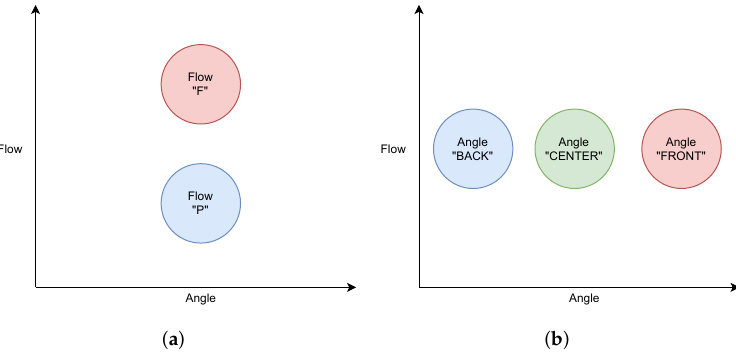
Figure 8. Ideal plot results for each parameter. ( a ) Ideal plot of flow rate. ( b ) Ideal plot of